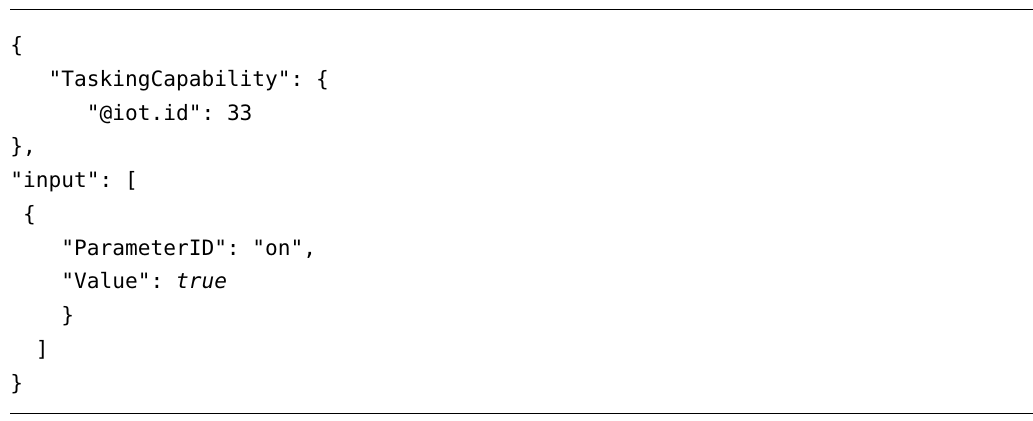
Figure 14. The remotely-controllable Liquid-crystal Display (LCD) and Light-emitting Diode (LED) device. Algorithm 5. An example task to turn on the LED.